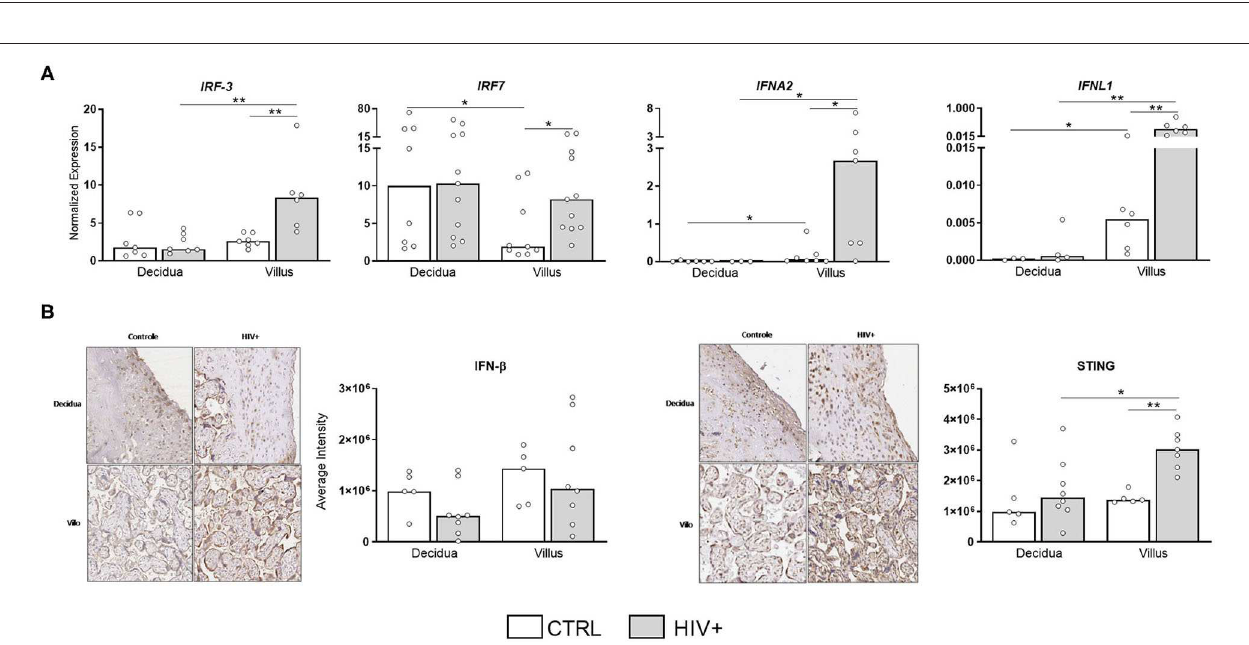
FIGURE 4 | Upregulation of type I and III IFN molecules in placental tissue of HIV-infected mothers. (A) mRNA expression levels of IRF3, IRF7, IFN α , and IFN- λ in decidua and placental chorionic villi from HIV-infected mothers (gray bar, n = 6–11) and UN mothers (white bar, n = 3–9) were evaluated by RT qPCR. (B) IFN- β and STING proteins levels were analyzed by immunohistochemistry in decidua and placental chorionic villi from HIV-infected mothers (gray bar, n = 7–8) and UN mothers (white bar, n = 5). Expression levels are represented as median. Mann-Whitney U or Wilcoxon signed-rank test: * p < 0.05, ** p < 0.01.